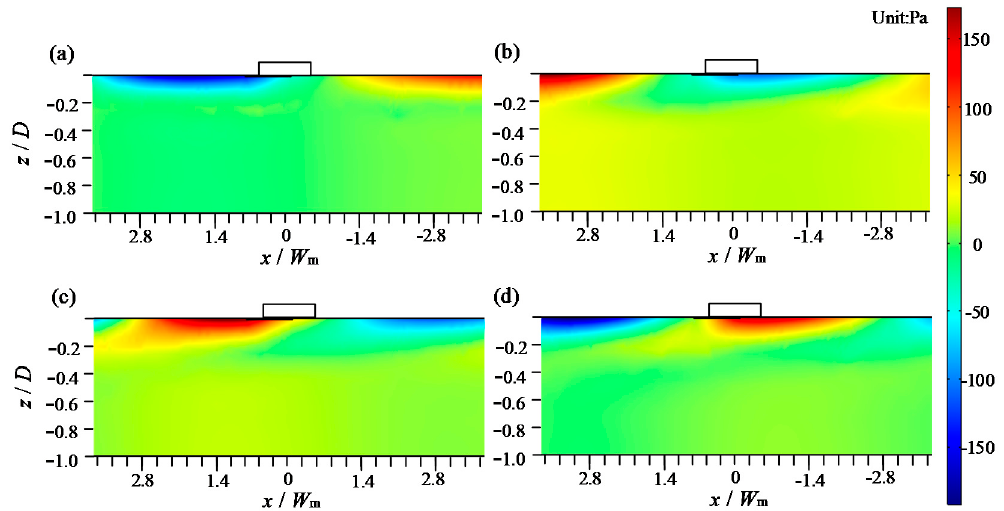
Figure 11. Contours of pore pressure in the vicinity of mat foundation from the numerical model of test 5 at different times: ( a ) 𝑡/𝑇 = 0.13 , ( b ) 𝑡/𝑇 = 0.38 , ( c ) 𝑡/𝑇 = 0.63 , ( d ) 𝑡/𝑇 = 0.98 .